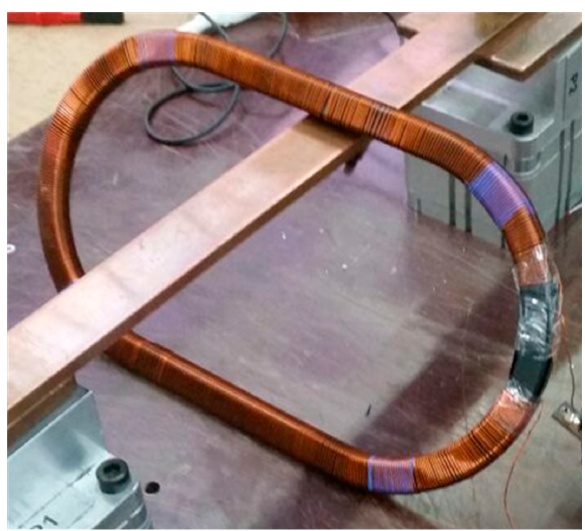
Figure 2. Current transformer core with distributed secondary winding.